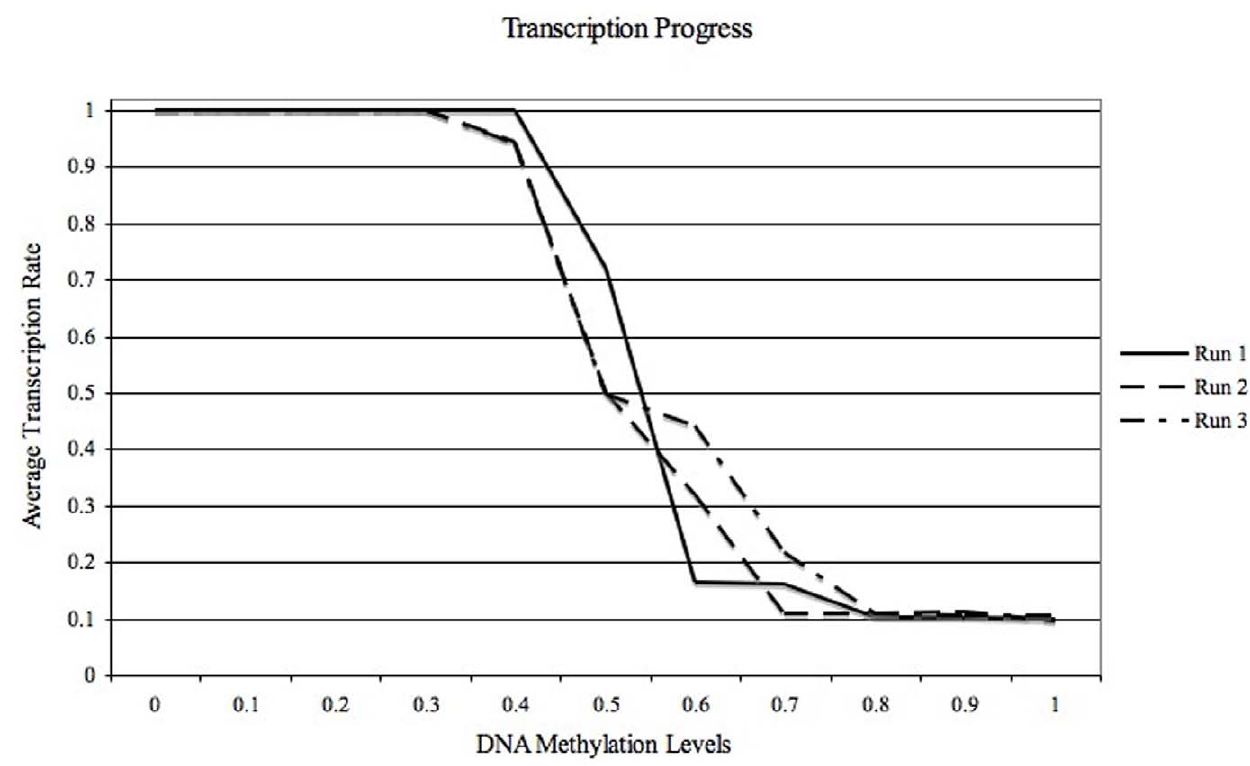
Figure 4. Average Transcription Progression derived for 16 Promoters over 5000 iterations during 3 different simulation runs. The third type of interaction between Transcription rate and DNA methylation level (or percentage) was observed here. Transcription rate (25 time- steps=1 time-interval) is inversely proportional to DNA methylation level (decided by user in this case, for testing purposes).